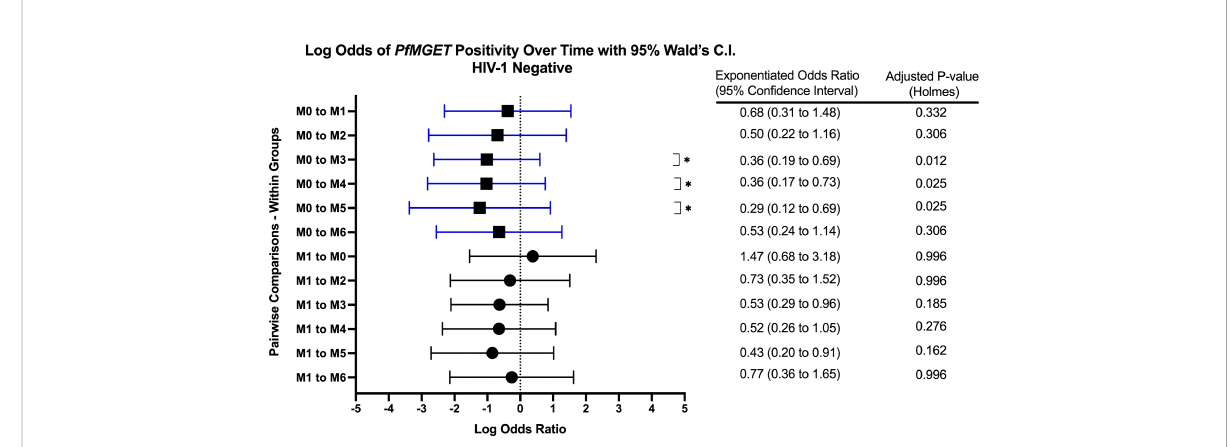
FIGURE 8 Forest Plot of the Log Odds of PfMGET Positivity in HIV-1 Negative Volunteers. The log odds and accompanying exponentiated adjusted odds ratio of being positive for at least one gametocyte speci fi c transcript within the HIV-1 negative study group between month 0 (M0) and between month 1 (M1). P-values were adjusted using the Holm ’ s method for multiple comparisons. Blue con fi dence interval lines are comparisons with month 0 and black con fi dence interval lines are comparisons with month